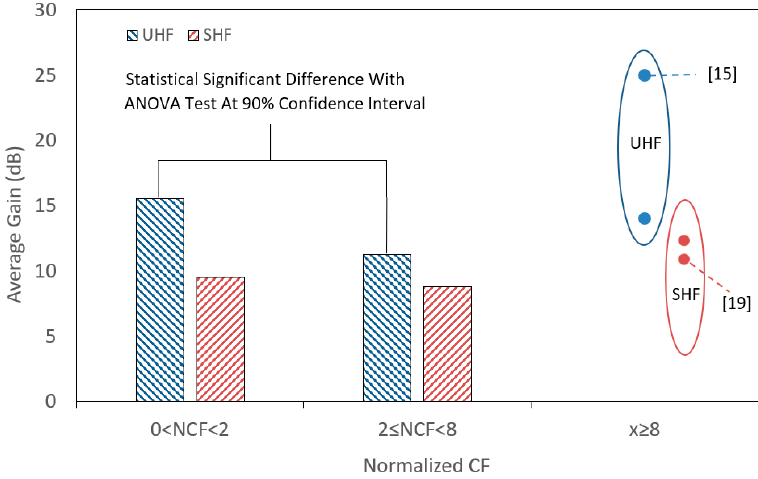
Figure 4. Plot of average gain against normalized CF for different applications. One-way ANOVA at 90% confidence level with statistically significant difference.